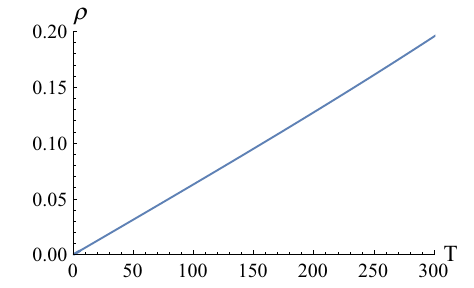
Fig. 1 The linear-T resistivity behavior in a large temperature range. Here, we have set k = 10 4 , which ensures k (cid:11) 1, (cid:6) (cid:11) 1 and (cid:6) z + (cid:11) 1